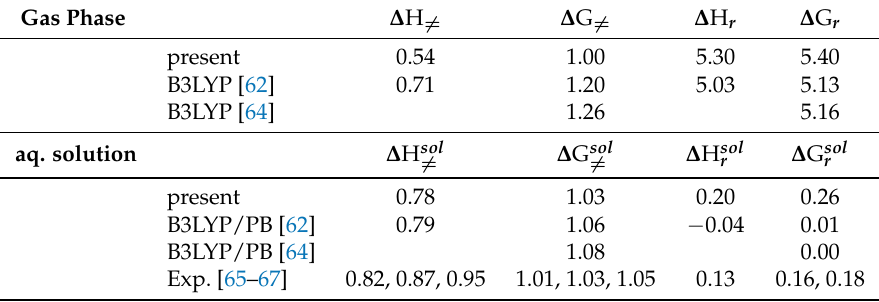
Table 5. Activation enthalpies ( ∆ H (cid:54) = ) and free energies ( ∆ G (cid:54) = ) variations for the first hydrolysis reaction of CP in both gas phase and aqueous solution. Corresponding reaction enthalpies ( ∆ H r ) and free energies ( ∆ G r ) are also reported. Aqueous solutions predictions from Refs. [62,64] were obtained by using the Poisson–Boltzman (PB) continuum solvent model. All values are in eV (1 kcal/mol = 0.043 eV).